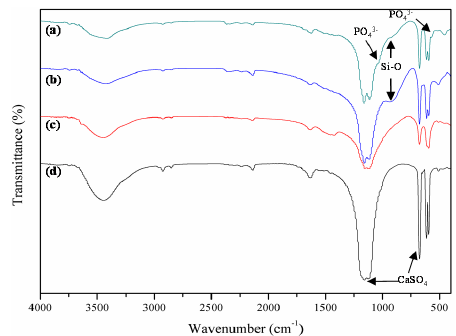
the composite scaffolds.